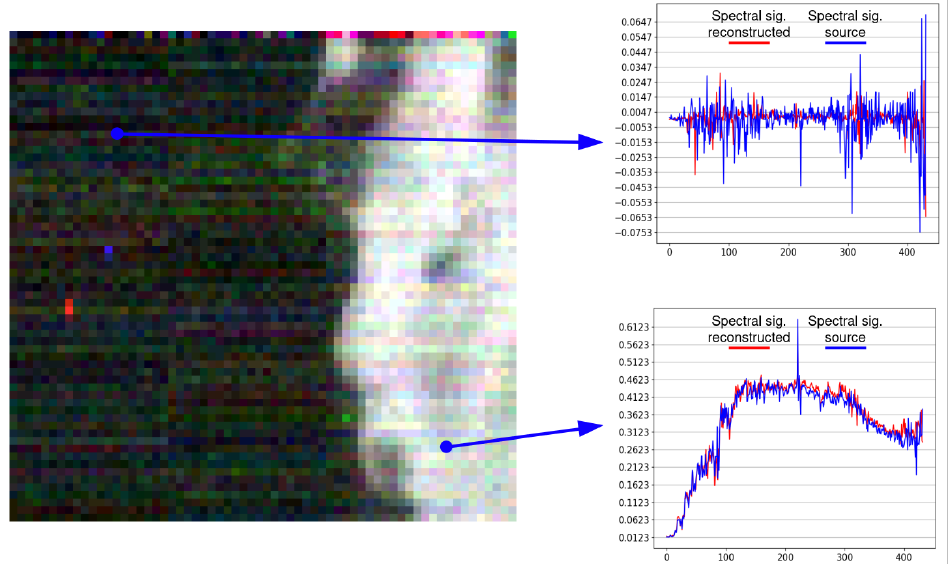
Figure 8. Differences between the source of the spectral signal (blue line) with the spectral signal reconstructed by SSCNet (red line) (last conv2d version) given two selected pixel coordinates (x, y) of the hyperspectral cube (source and reconstructed, respectively) on all available bands of the VIRTIS-Rosetta data (Compression Ratio